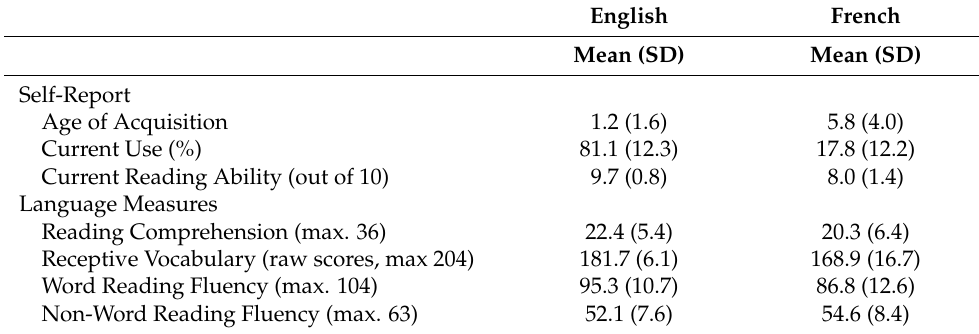
Table 1. Means and Standard Deviations on Self-Report Language Use and on Language